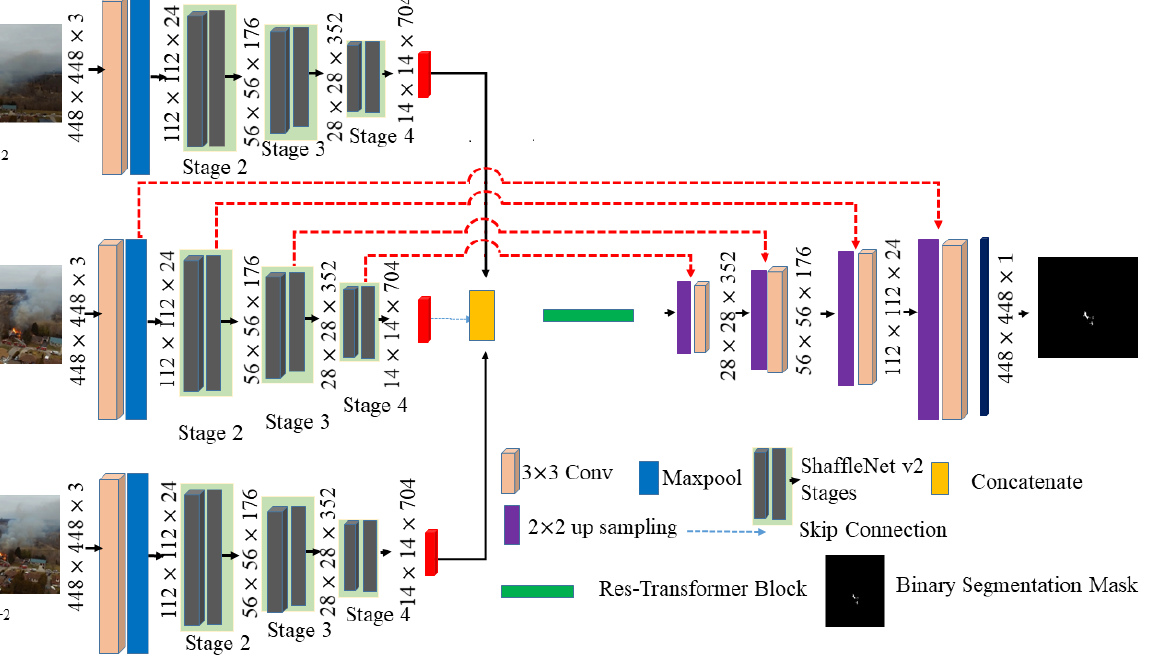
Figure 2. The architecture of our proposed FFS-UNet network. It comprised two paths: the encoder path was accountable for extracting spatiotemporal features for understanding view transformation. At the same time, the decoder path was used to retrieve progressively more refined attributes by combining information from the peer-encoder